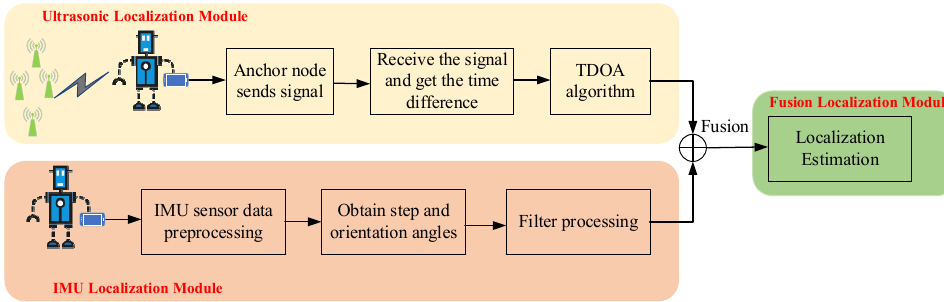
Figure 1. Overall scheme of the fusion localization system.